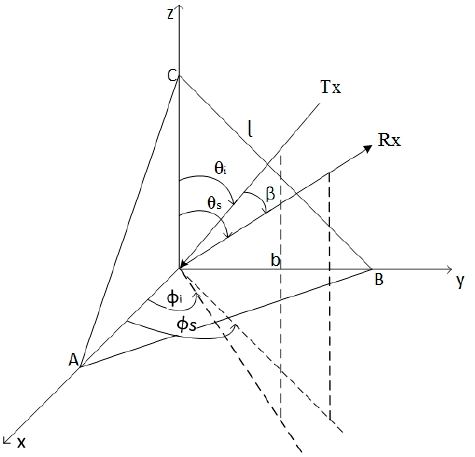
Figure 6. The bistatic RCS observation geometry of the TCR.